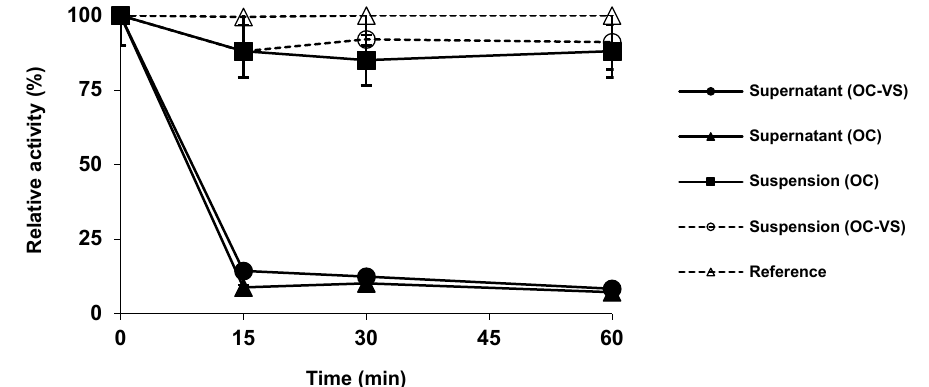
Figure 1. Immobilization courses of CALB (1 mg/g) on octyl (dotted line and empty symbols) and octyl-VS (solid line and symbols) beads at pH 5 and 25 ◦ C. Experiments were performed as described in Methods.